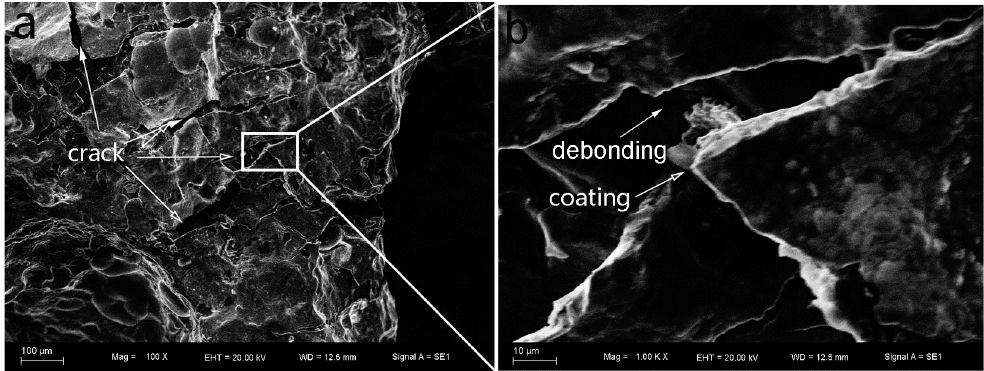
Figure 11. Failure of Ni/Al hybrid foams at room temperature: ( a ) 100× and ( b ) 1000×.